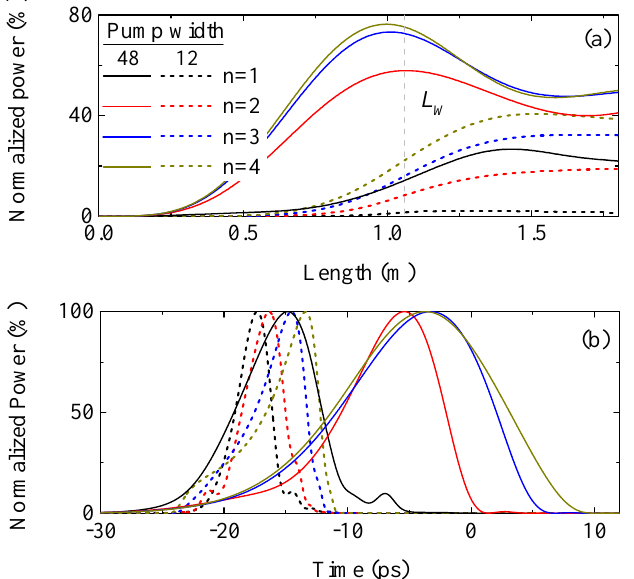
Figure 4. ( a ) Normalized power at the output core as function of the fiber length for several pump pulses with different shape and FWHM. ( b ) Temporal profile of the switched pulse for the aforemen- tioned pump pulses at the fiber length with maximum power transfer for the output